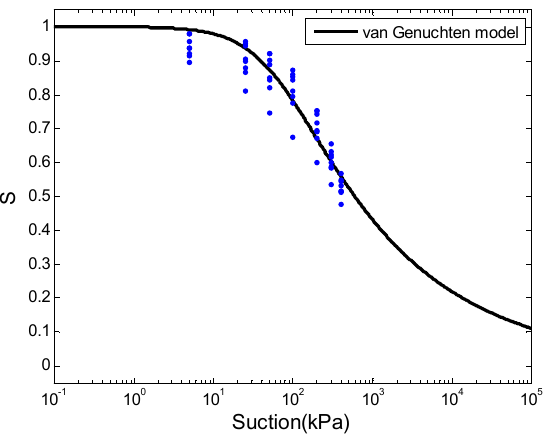
Figure 2. Fitted soil–water characteristic curve (SWCC) using optimal model parameters and laboratory data.